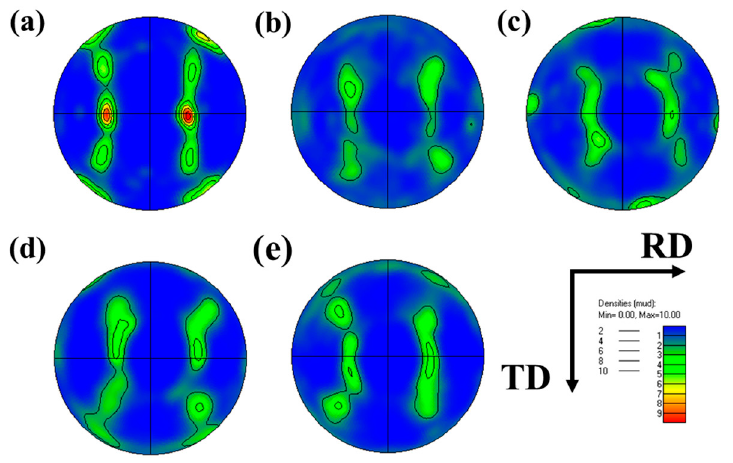
Figure 14. Texture types at different temperatures: ( a ) original; ( b ) 400 °C; ( c ) 425 °C; ( d ) 450 °C; ( e ) 475 °C.